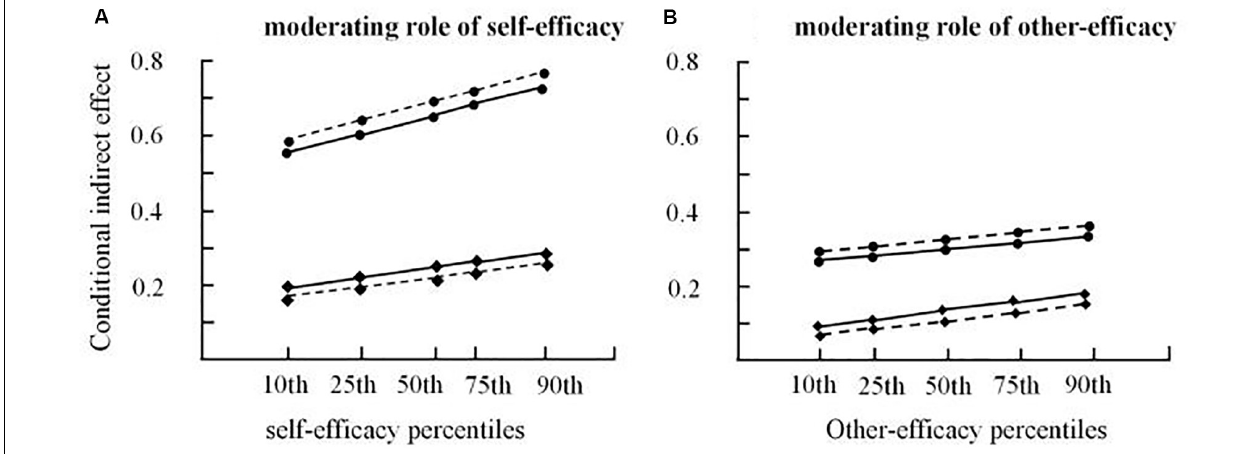
FIGURE 2 | Conditional indirect effect. (A) Moderating role of self-efficacy. (B) Moderating role of